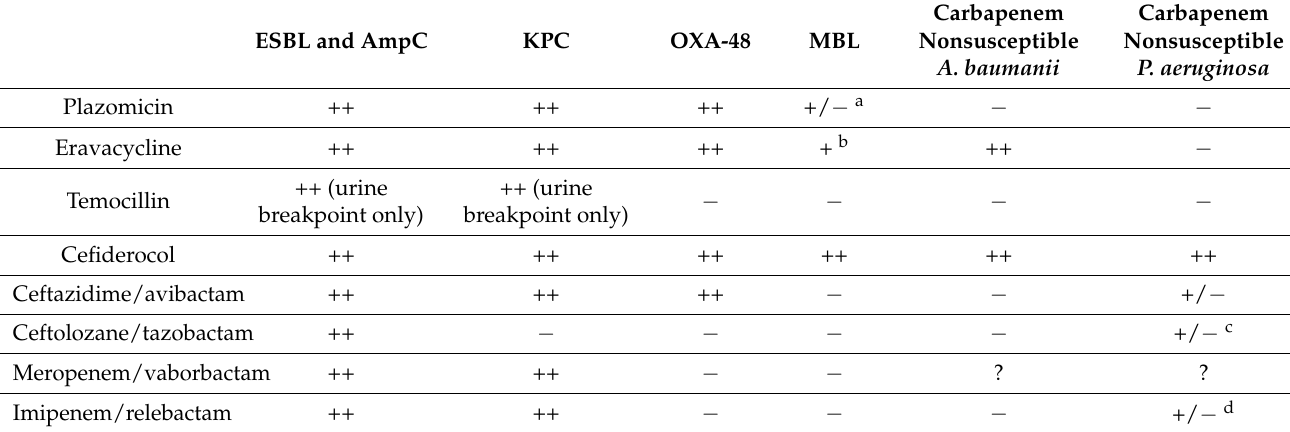
Table 5. Possible applications of new antibiotics against Gram-negative bacteria based on resistant mechanisms. ESBL and AmpC KPC OXA-48 MBL